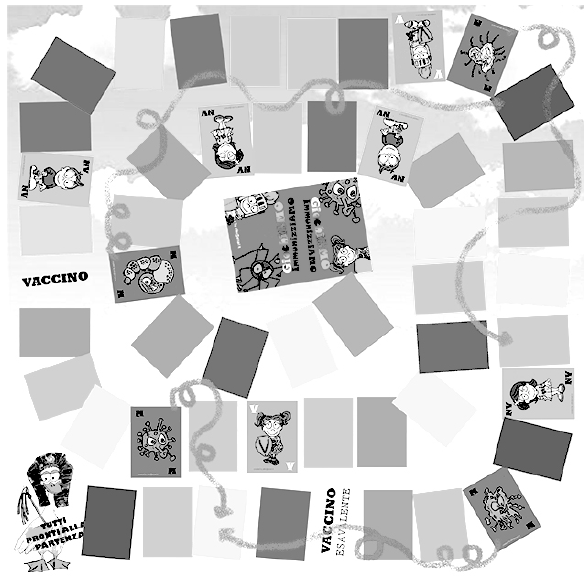
Figure 2. The Vaccine Goose board game.